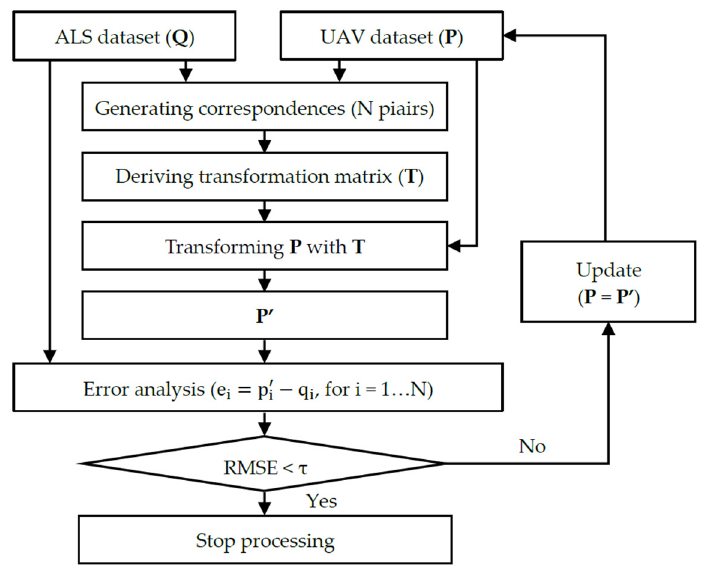
Figure 2. A conceptual model of ICP processing for UAV-SfM and ALS point cloud referencing transformation.